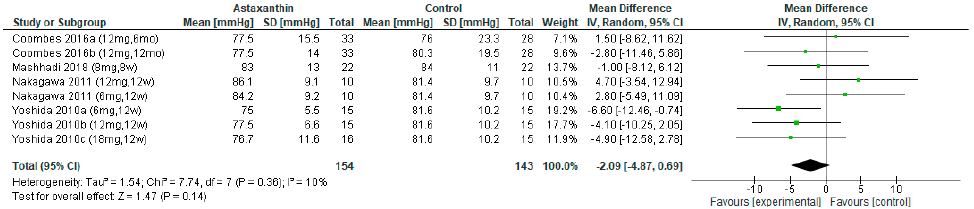
Figure 5. Forest plot of the effect of astaxanthin on diastolic blood pressure [26–28,31]. Bold means total data.